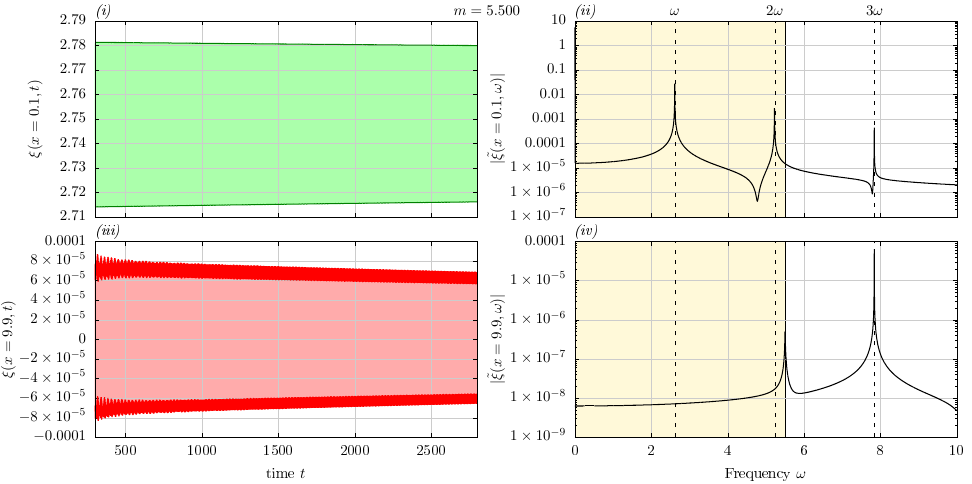
Figure 10 . Slow decay of the oscillational mode for the p = 2 case through the third harmonics. The left panels show the time dependence of the (cid:12)eld oscillations near the center (i) and at a certain distance from the skyrmion core (iii) . The right panels show the power spectrum of the oscillations. Note that the second harmonics this time is below the mass threshold and cannot propagate (no sign of it in (iv)